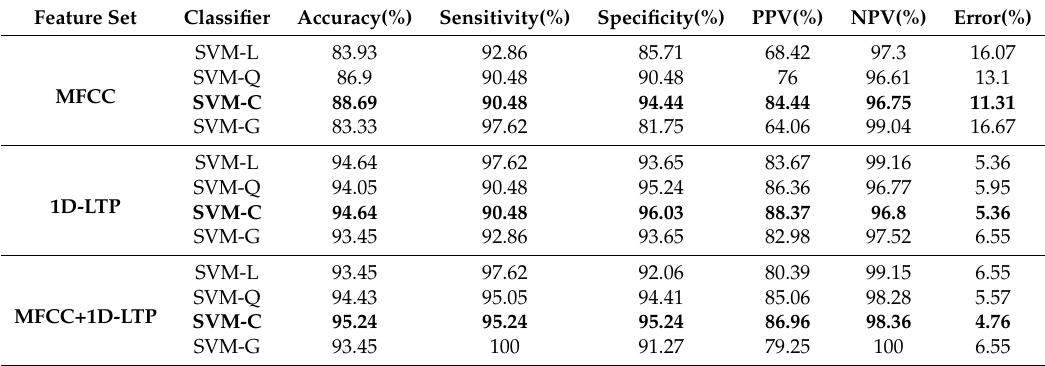
Table 6. Performance comparison of SVM using different feature sets for multiclass experiments. Bold font indicates the best result obtained against each feature